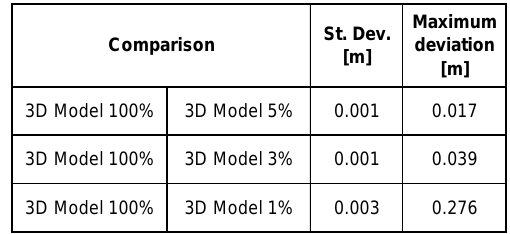
Table 2. Polygonal decimation of the 3D Model To check the variation of accuracy as regards the decimation rate, the original 3D model was compared to the resampled models. While the file size was reduced proportionately, the geometrical accuracy has changed just a little. The standard deviation and the maximum deviation were calculated in a 3D comparison between original model and resampled models. The results for 5% and 3% resampled models was almost the same; in 3D comparison between original and 1% versions the standard deviations were already higher by a factor of 3 (Table 3). The maximum deviations vary from 1.7 cm for 5% version to 27.6 cm for 1% version. So only polygon decimation until 3% could be achieved for the Telamon without significantly losing geometrical and visual quality.